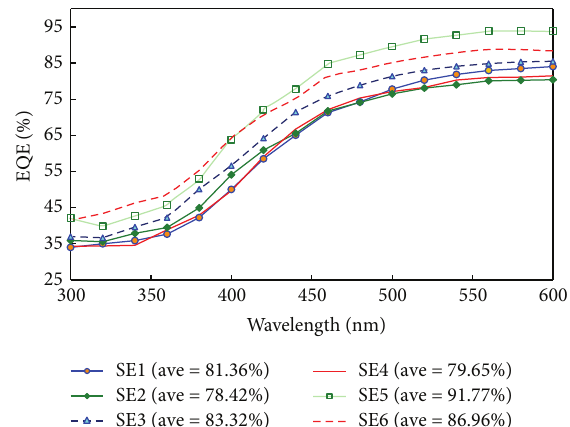
and 𝑉 sections. SC OC